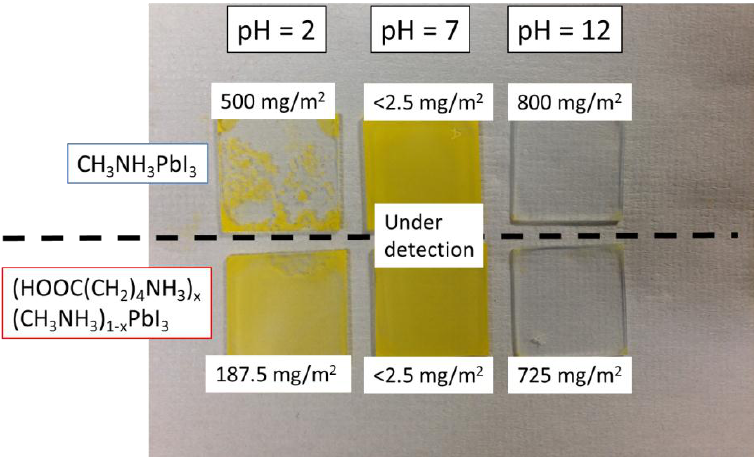
Figure 6. Pictures of the one-step-processed CH 3 NH 3 PbI 3 perovskite layers with/without 5-aminovaleric acid (5AVA) doping, dipped in water, aqueous HCl solution (pH = 2) and aqueous NaOH solution (pH = 12). The numbers inserted in the picture show the amount of the lead dissolved into the water, the aqueous HCl solution (pH = 2) and the aqueous NaOH solution (pH =